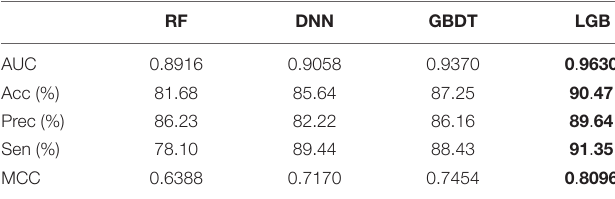
TABLE 7 | Performance comparisons on Check808.